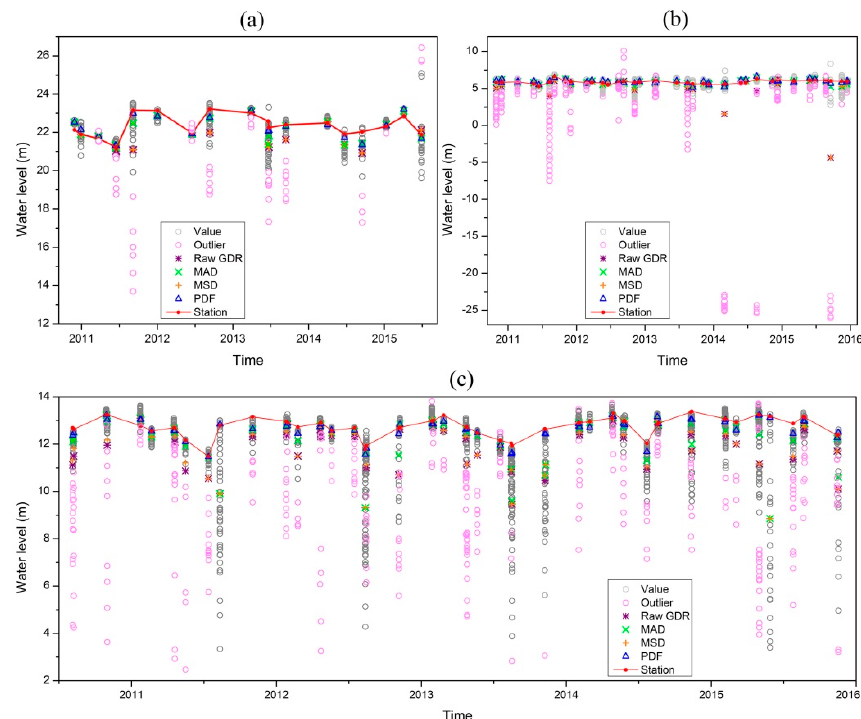
Figure 4. Altimetry and in situ station gauging lake levels for ( a ) Luoma Lake, ( b ) Gaoyou Lake, and ( c ) Hongze Lake. Circles are GDR values for each along-track segment, in which the light magenta circles are outliers. Red dots are station gauging water levels, while blue triangles, green “ × ”, orange “ + ”, and purple “ ∗ ” are altimetry water levels detected by the concentrated PDF, the median absolute deviation (MAD) method, the mean and standard deviation (MSD) method, and the raw GDR, respectively.